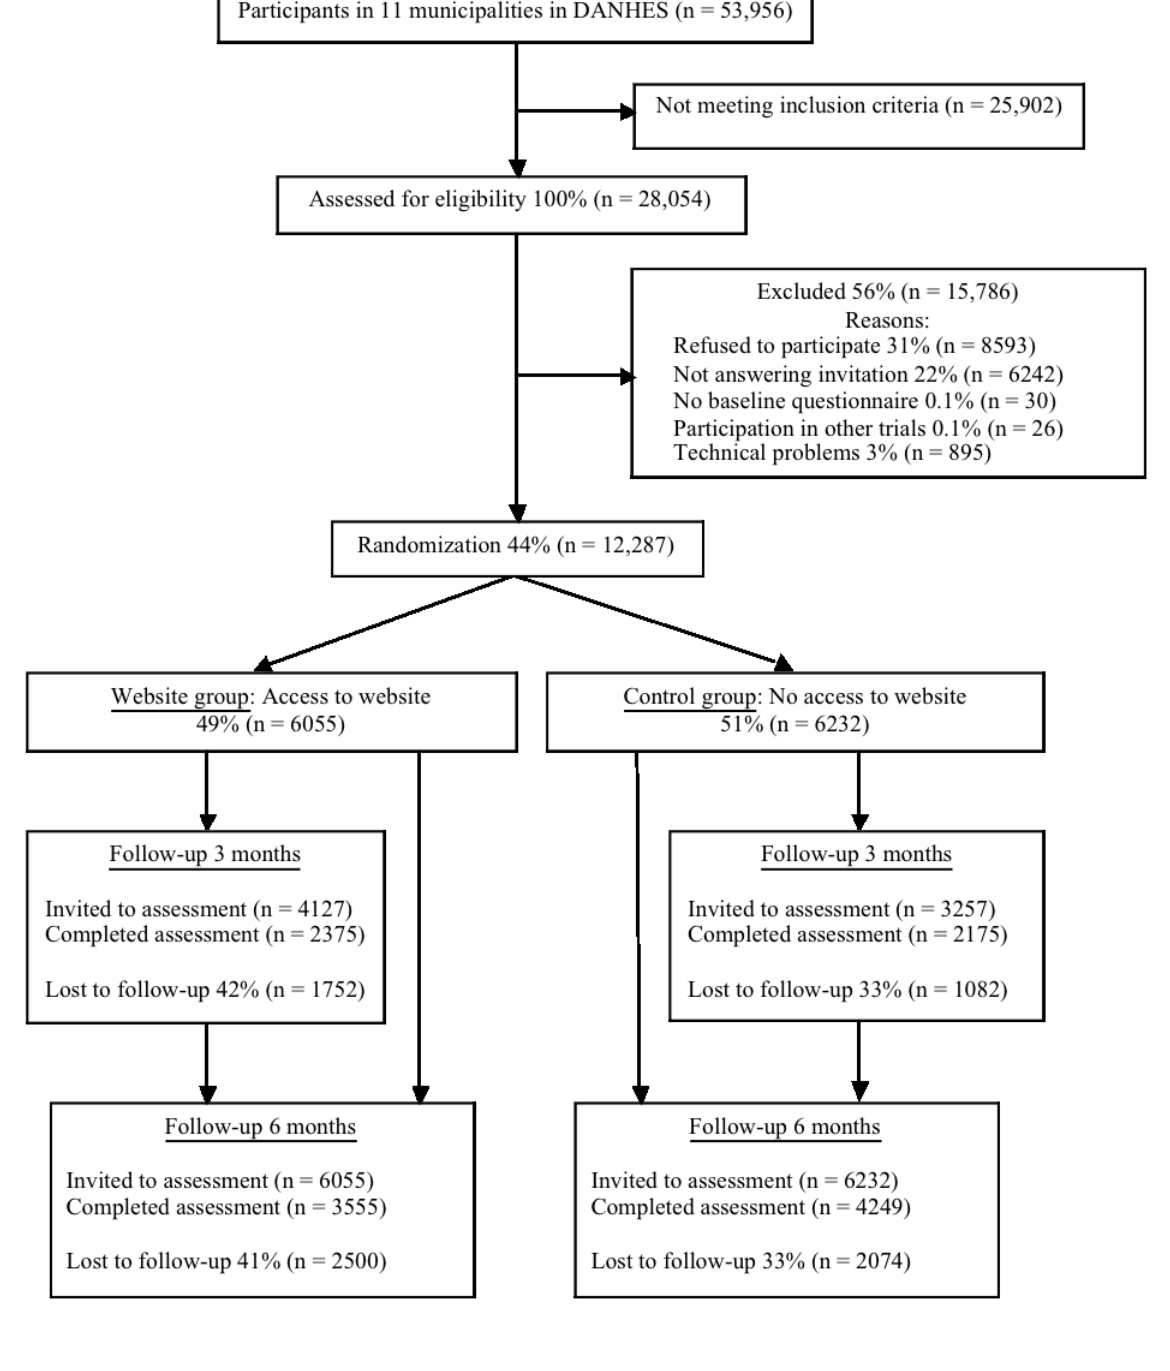
Figure 1. Flow diagram of the Web-based intervention (Denmark, 2008). DANHES = Danish Health Examination Survey